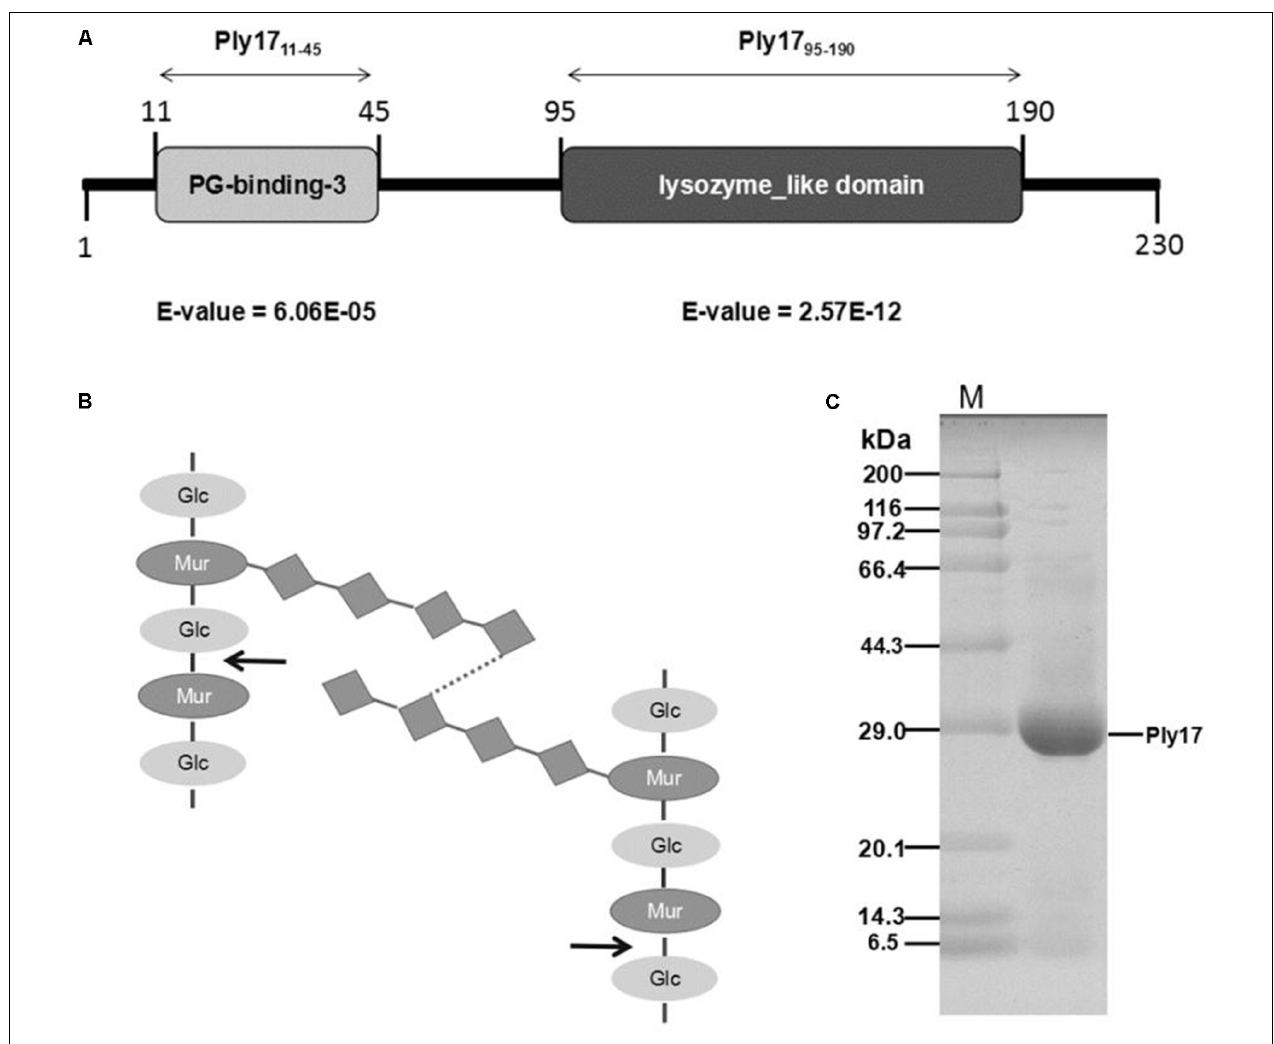
FIGURE 1 | Ply17 modular architecture and purification. (A) Schematic representation of the domain organization of Ply17. Conserved cell wall binding domains and catalytic domain are annotated and displayed as light gray and dark gray boxes, respectively. (B) The structure of peptidoglycan is shown, and Ply17 is predicted to digest the beta-1,4-linked polysaccharides. The digestion site is indicated with an arrow. (C) Purified Ply17 protein is observed in SDS-PAGE (15%) stained with Coomassie Brilliant